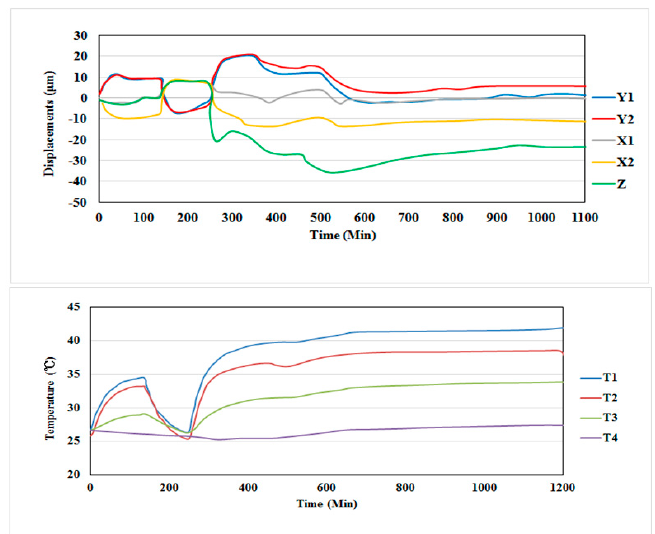
Figure 12. Temperature and displacement variations on the x -, y -, and z -axes under the activation of temperature compensation system.